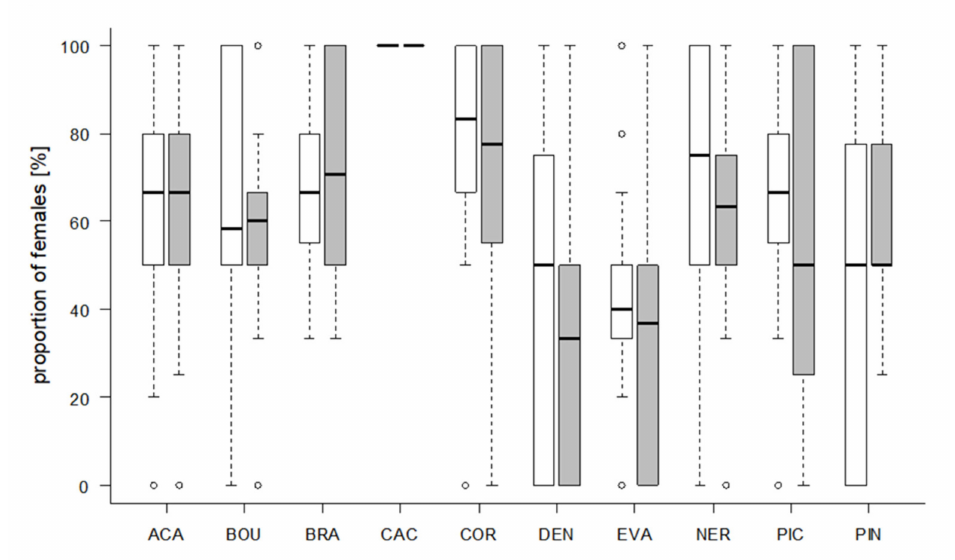
Figure 6. Percentage of female o ff spring per Trichogramma strain developed in S. cerealella (white) and T. absoluta (grey) eggs. Box plots denote median (solid line), whiskers show range of data, and circles represent